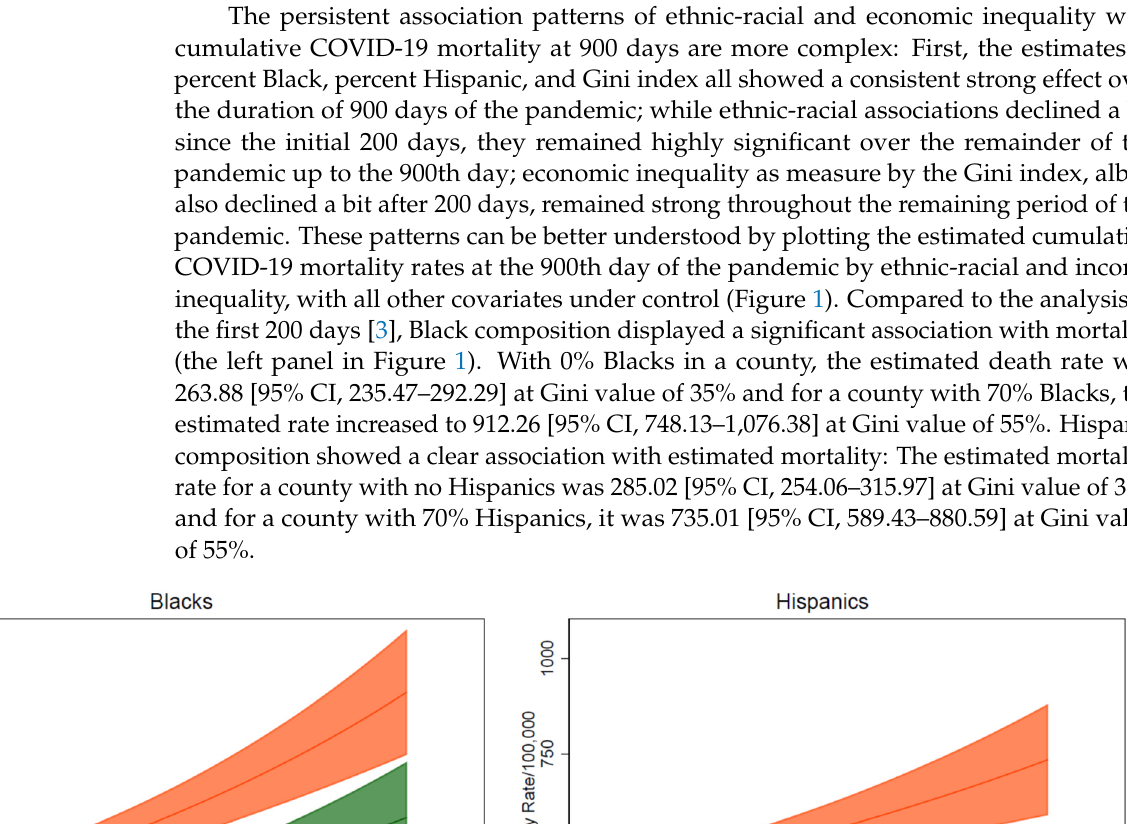
Table 2. Estimated Incidence RR From Multilevel Negative Binomial Models of Incidence in 3141 US Counties.